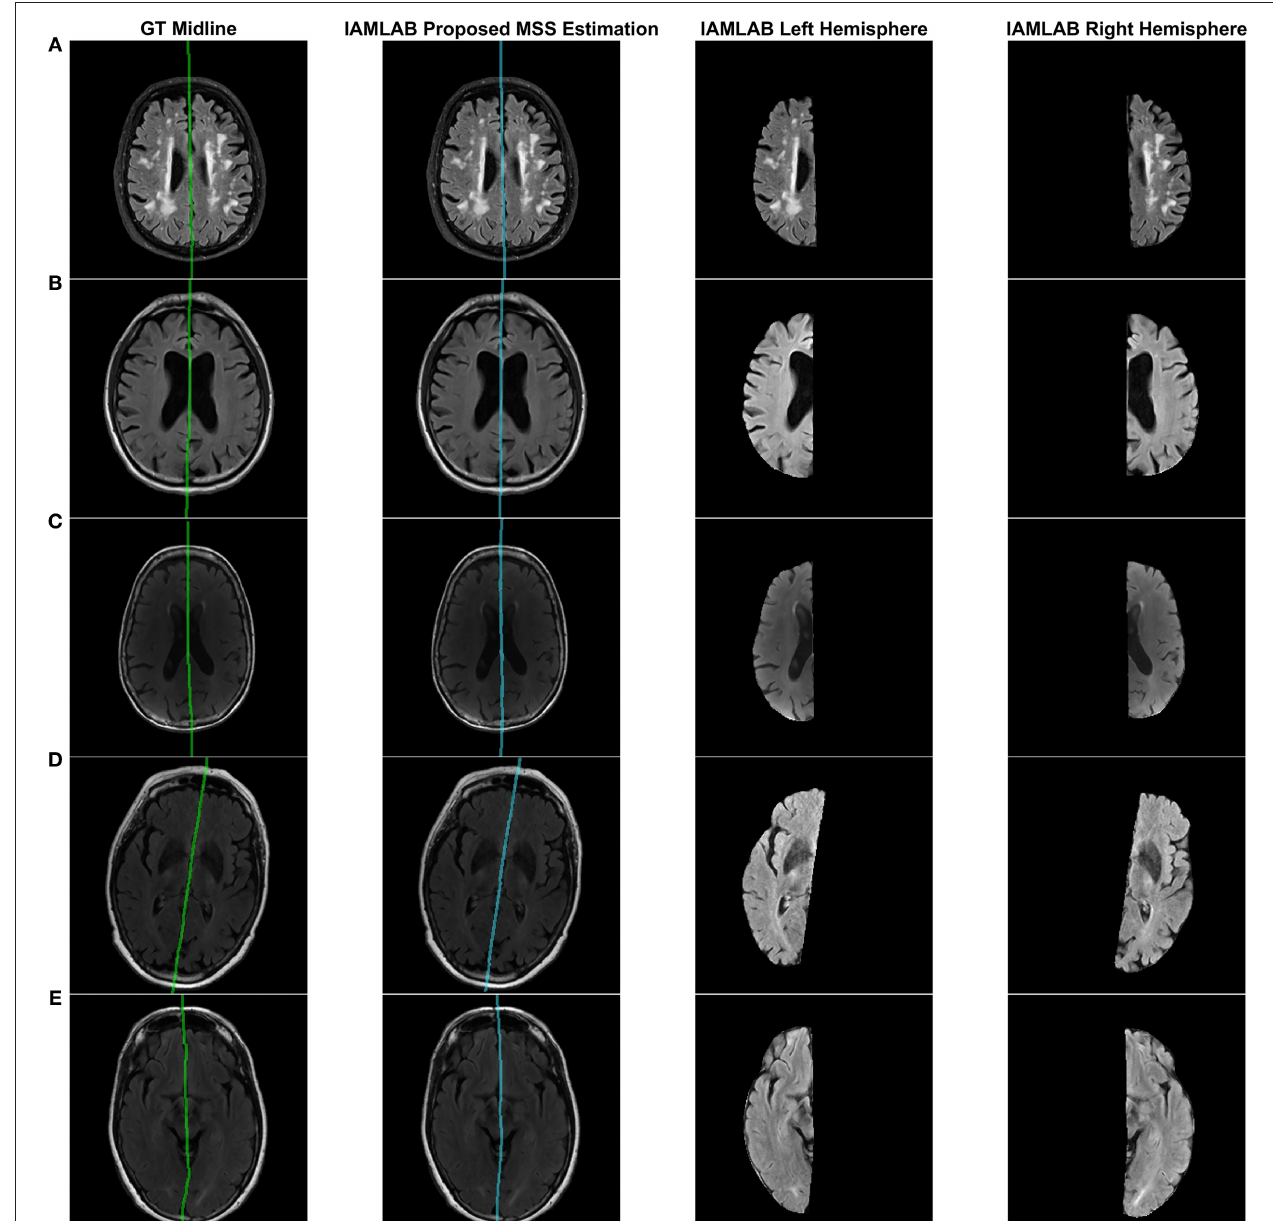
FIGURE 3 | Visualizing midline estimations and extracted hemispheres of various cases using the proposed method. From left to right: ground truth midline, estimated midline, left hemisphere, right hemisphere. The cases shown are: (A) High lesion load, (B) Enlarged ventricles, (C) Dark contrast, (D) Head angled, and (E) Curved LF.